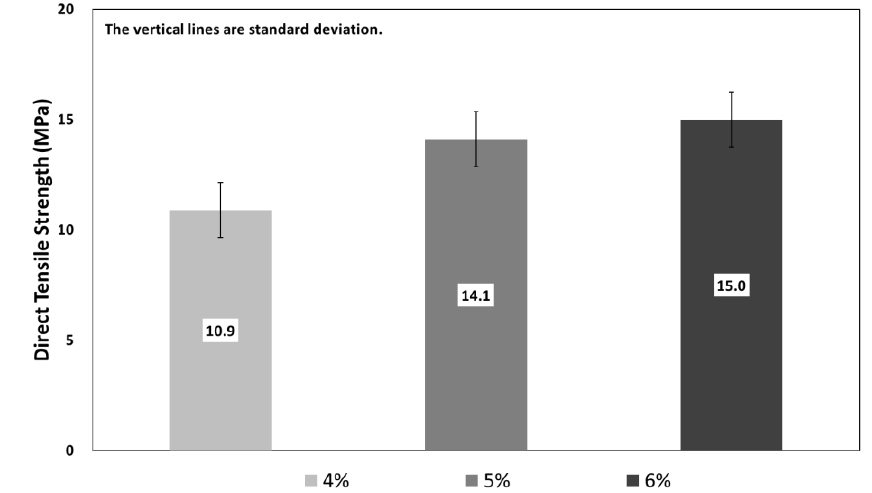
Figure 6. Direct tensile strength with respect to fiber volume fraction.